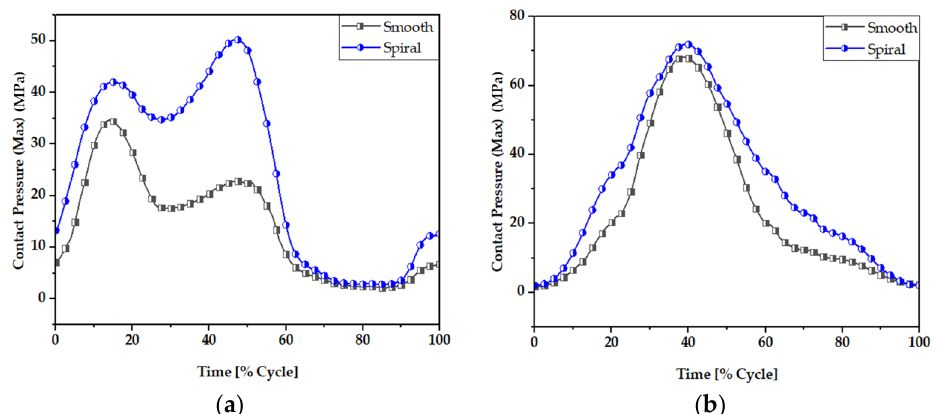
Figure 7. Maximum contact pressure (MPa) of smooth and spiral head-neck tapered joints during ( a ) walking and ( b ) jogging loading conditions.